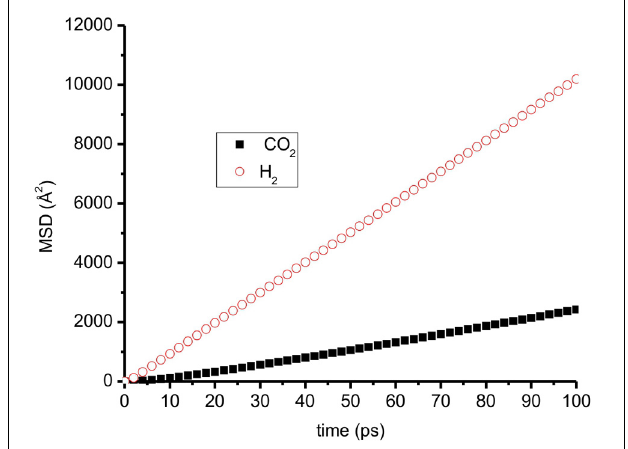
FIGURE 9 | The mean-squared displacement (MSD) of CO 2 and H 2 on a graphite surface at T = 300K, N = 700, mole fraction of CO 2 = 0 . 3 H 2 has much higher MSD than CO 2 .